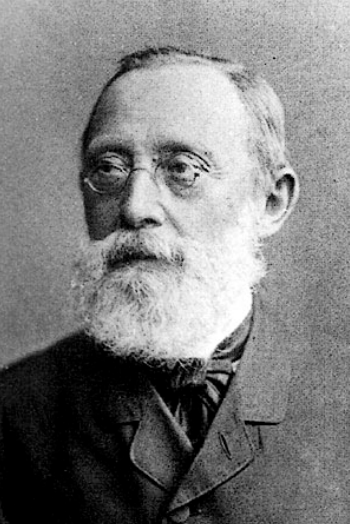
Figure 1. “Rudolf Ludwig Karl Virchow,” photographed by J. C. Schaarwächler in 1891, repro- duced with permission from the Wellcome Medical Museum, London,